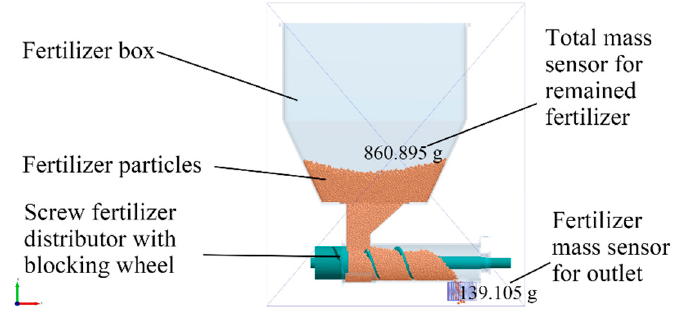
Figure 3. Simulation model and mass sensors.